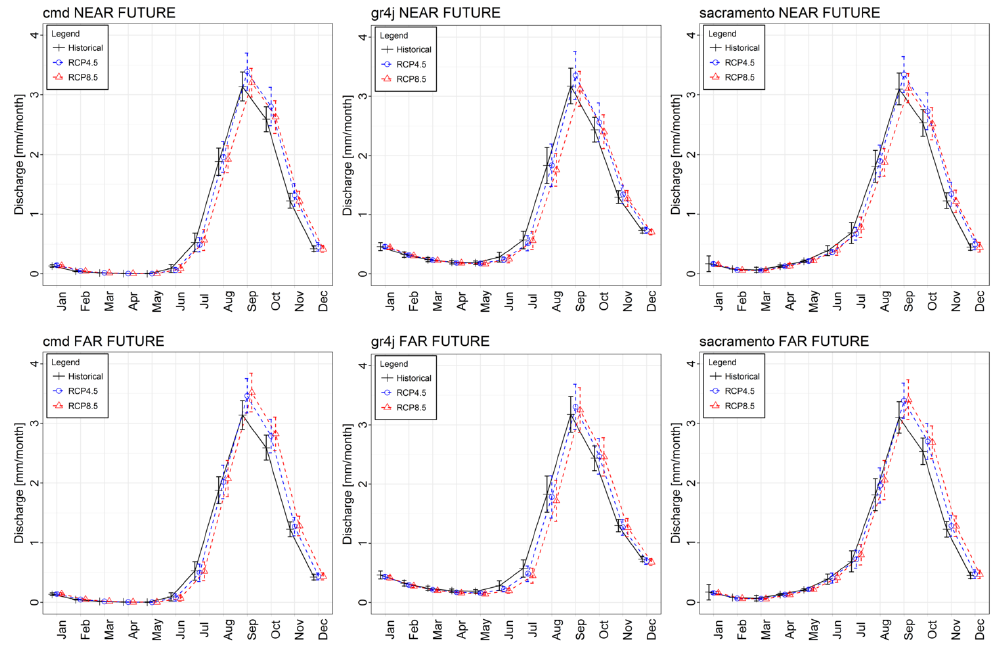
Figure 5. Effect of model structure uncertainty on ensemble simulated mean monthly discharge from eight GCMs in the past (1951–2005), as well as the near (2010–2035) and far (2036–2099) future.